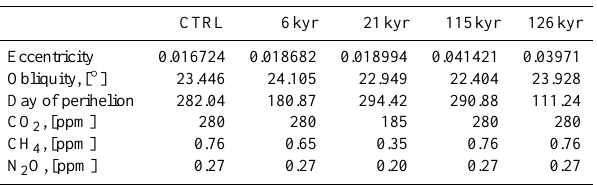
Table 1. Orbital parameters and greenhouse gas concentrations for the CTRL, 6, 21, 115 and 126kyr simulations derived from the PMIP2